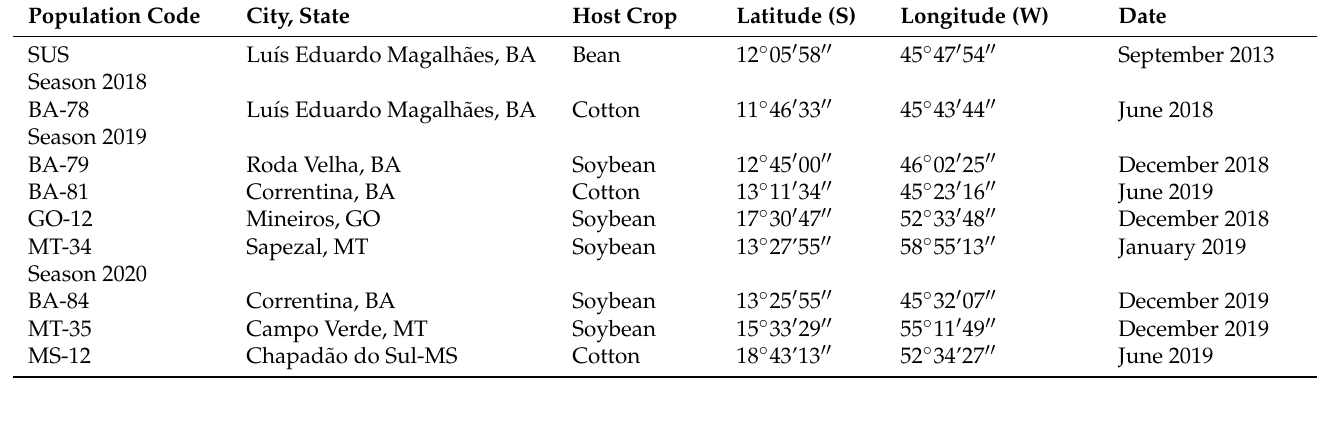
Table 1. Populations of Helicoverpa armigera used for the characterization of the baseline susceptibility and validation of the diagnostic concentration to HearNPV.